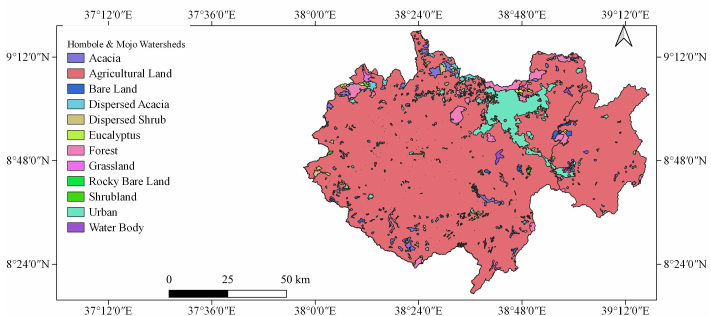
Figure 12. Land use map of the Hombole and Mojo Watersheds from 2013 to 2015.